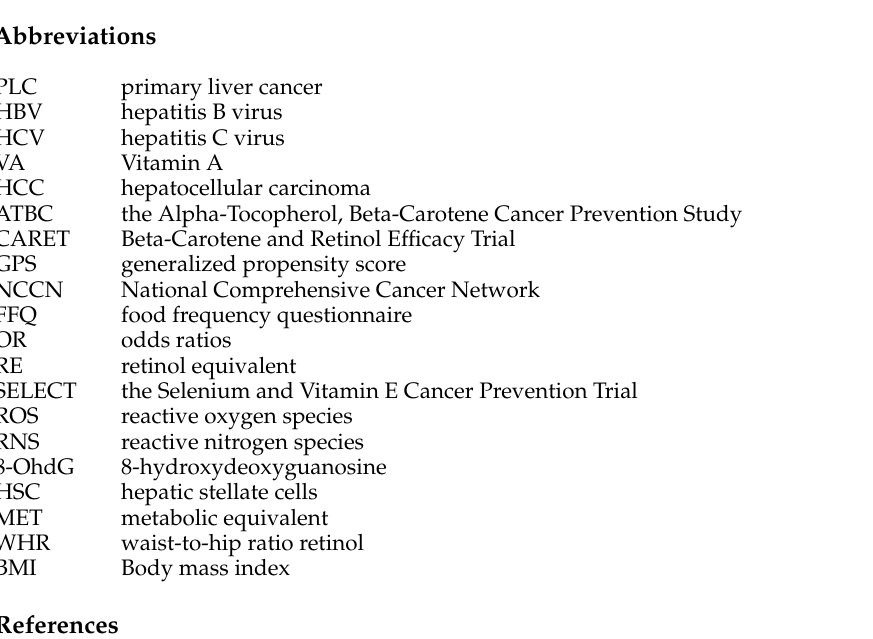
Table S1: Odds ratios (OR) and 95% confidence intervals (CI) of primary liver cancer according to quartiles of carotene-rich and retinol-rich food intake, Table S2: Food contents of RE and the amount of foods providing vitamin A of 1000 µ g